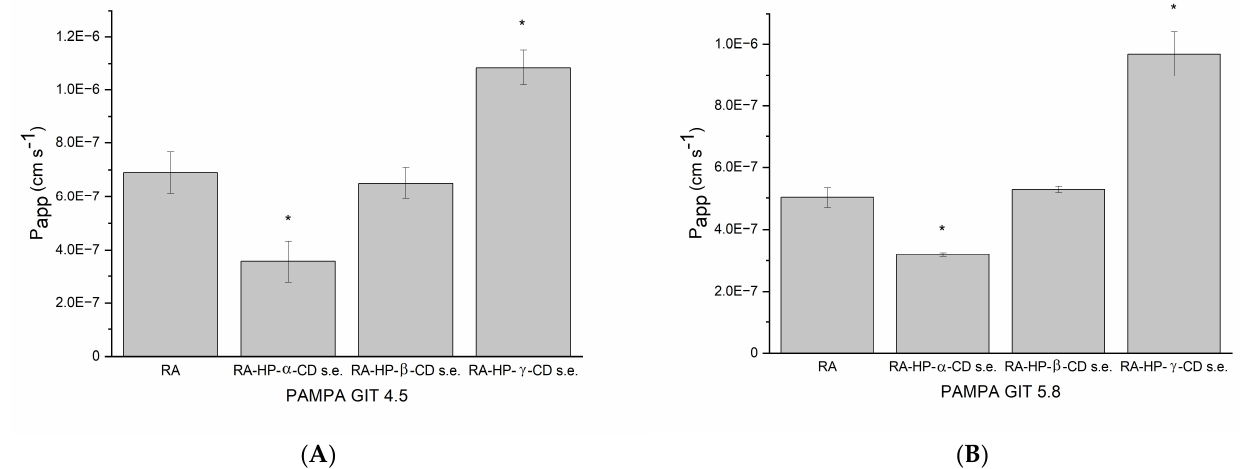
Figure 8. Apparent permeability coefficient values of RA and RA in binary systems prepared by the solvent evaporation method: RA–HP-α-CD s.e., RA–HP-β-CD s.e., RA–HP-γ-CD s.e. in a pH of 4.5 ( A ) and in a pH of 5.8 ( B ). (*) indicates statistically significant differences, p < 0.05.